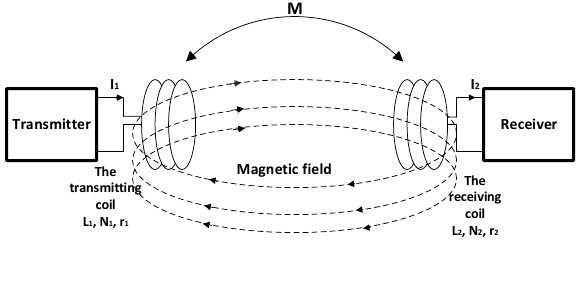
Figure 6. Typical inductive coupling system The WPT setup has three main functional blocks consisting of a transmitter circuit, a receiver circuit, and a coupling device, as illustrated in Figure